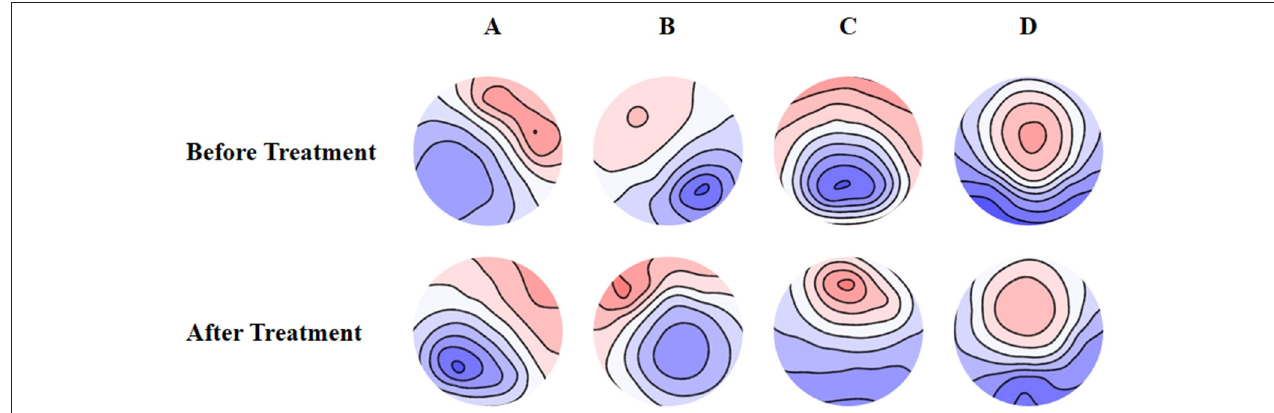
FIGURE 1 | Spatial configuration of the four microstate classes. (A) Microstate A; (B) microstate B; (C) microstate C; (D) microstate D. Blue regions are negative and red are positive relative to average reference. The top row shows the EEG topoplots for the microstates identified before treatment, and the row under it shows the EEG topoplots for the microstates identified after treatment with